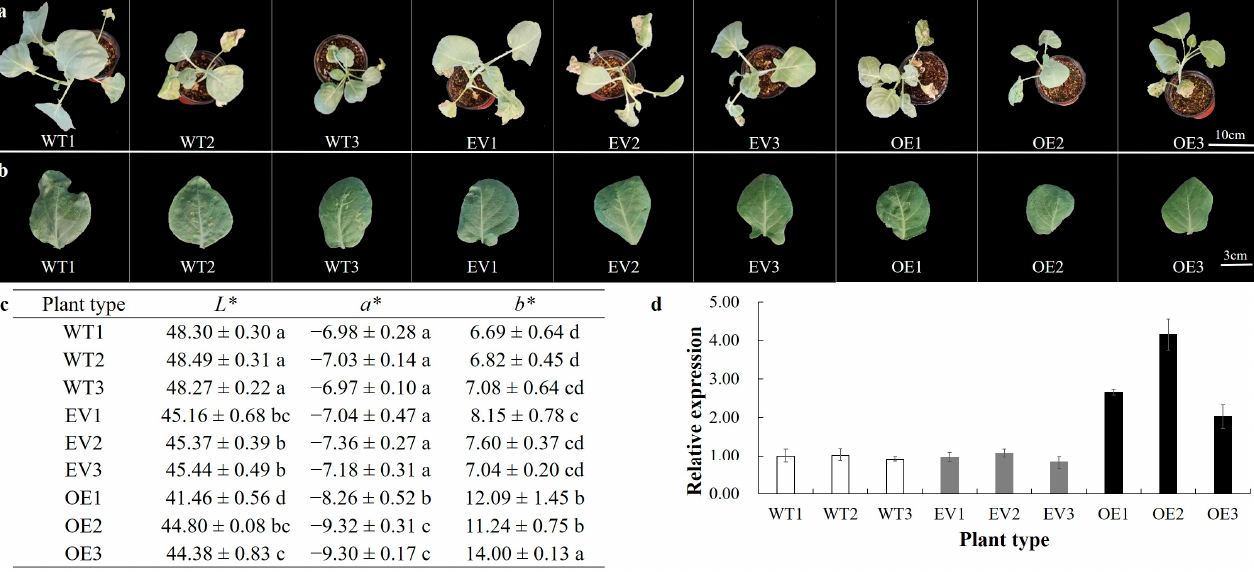
Figure 4. The phenotypes and expression of BoaNXS in wild-type (WT), the agroinfiltrated plants with empty vector (EV),